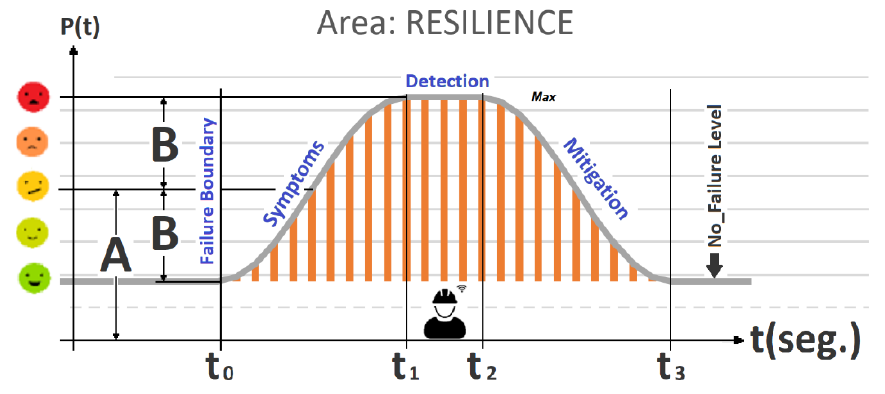
Figure 11. Resilience for real-time data. A is the No_Failure Level plus B, where B is the cosine amplitude. The maximum performance value curve (raised cosine) is shown in Equation (1).